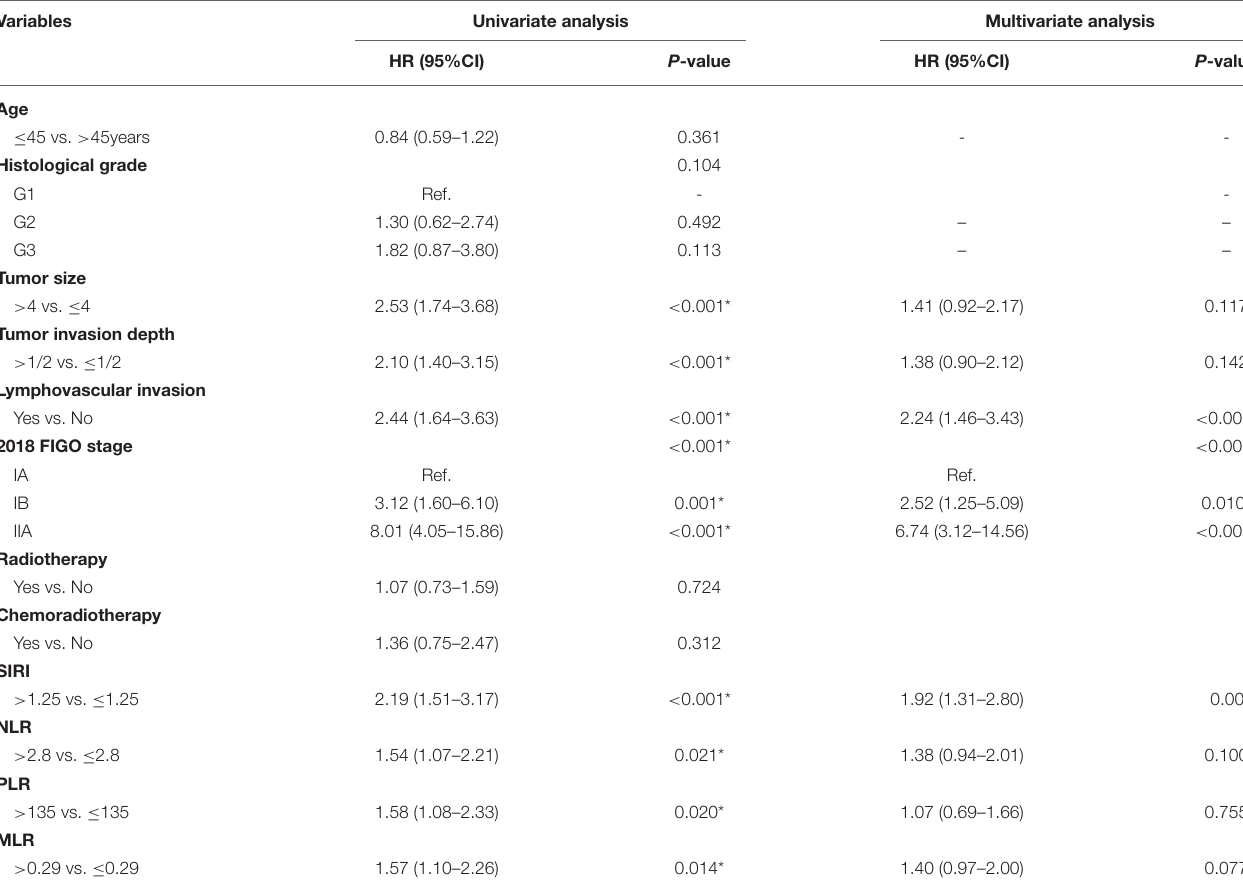
FIGO, International Federation of Gynecology and Obstetrics; SIRI, systemic inflammation response index; NLR, neutrophil lymphocyte ratio; PLR, platelet lymphocyte ratio; MLR, monocyte lymphocyte ratio; HR, hazard ratio; CI, confidence interval; Ref, reference. * Statistically significant (P < 0.05).